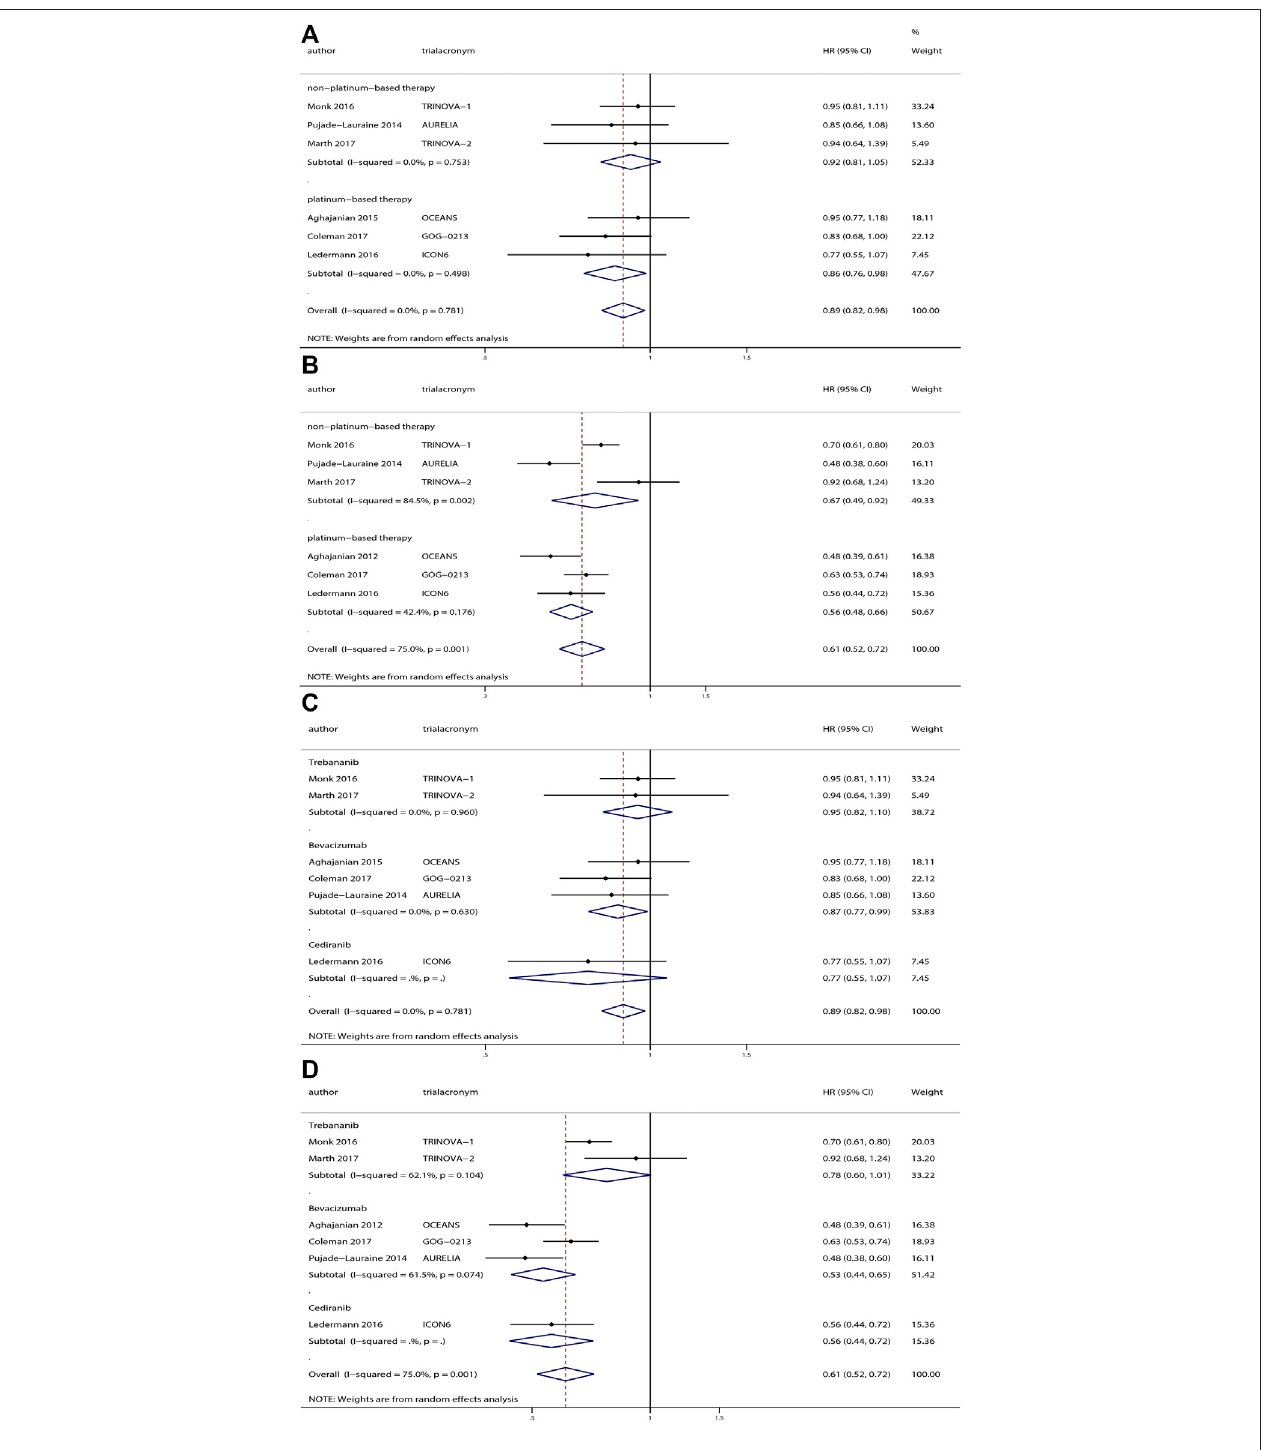
FIGURE 5 | Subgroup analyses of anti-angiogenesis treatment vs placebo in relapsed ovarian cancer. Subgroup analyses based on platinum-based therapy or non – platinum-based therapy: (A) overall survival (OS) and (B) progression-free survival (PFS). Subgroup based on drugs: (C) OS and (D) PFS.